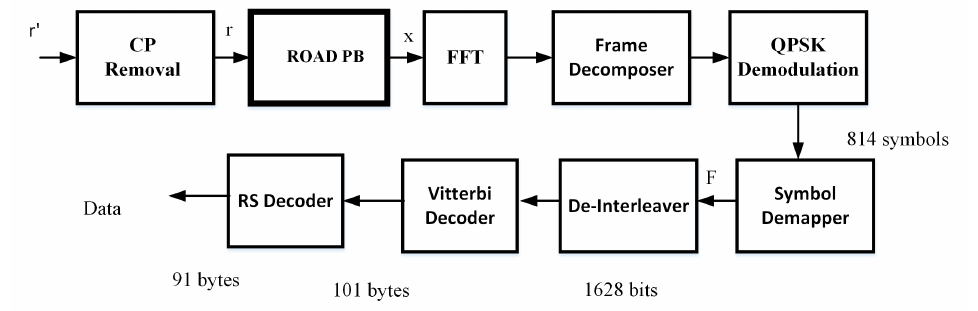
Figure 4. Proposed LDACS receiver block